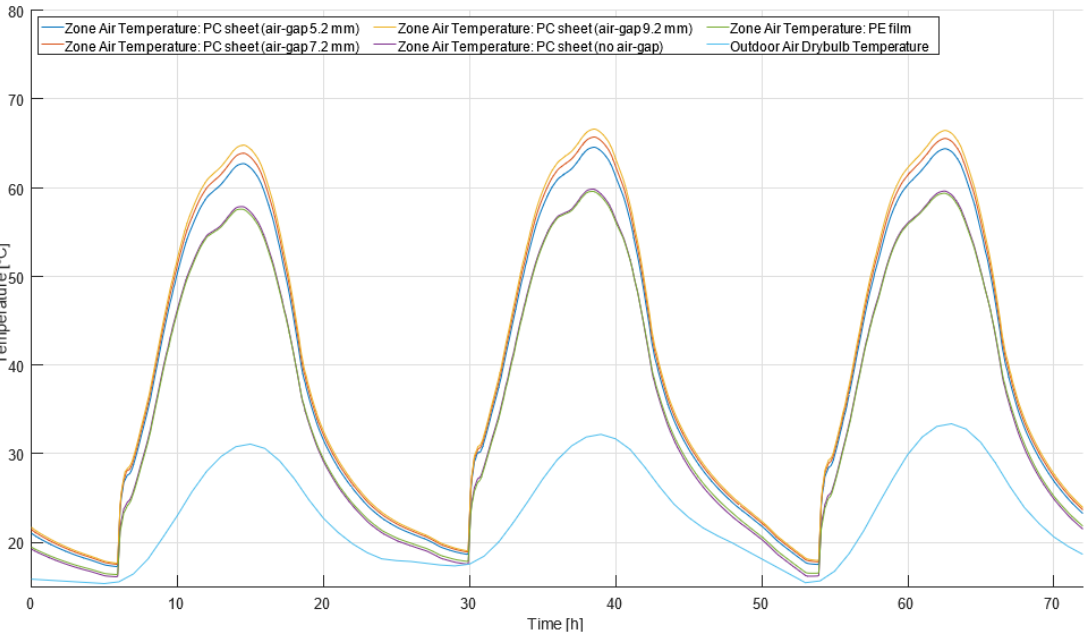
Figure 4. Unconditioned temperature inside and outside the greenhouse between the 13 and 15 of August for the different glazing materials.